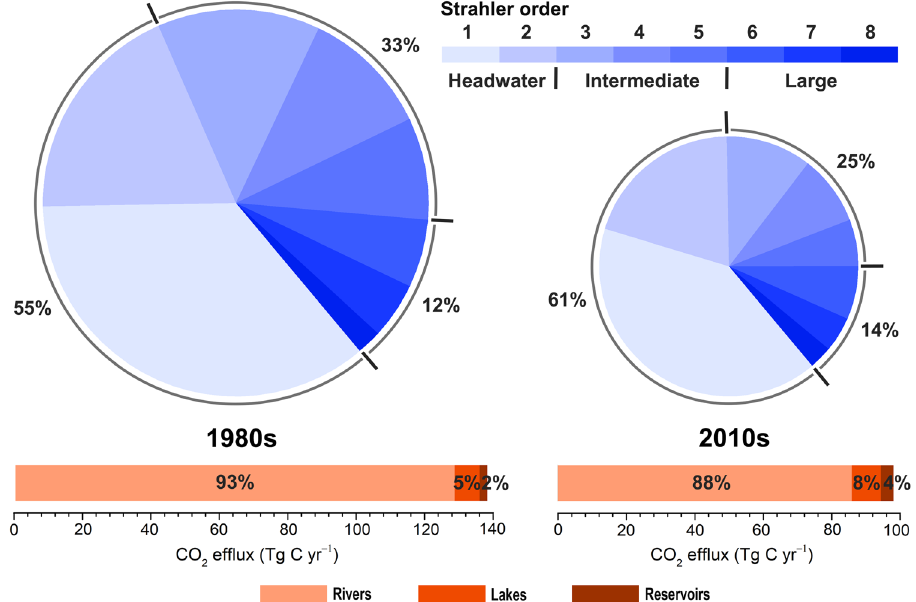
Fig. 3 Comparison of CO 2 emissions from Chinese inland waters in the 1980s and 2010s. Upper: relative importance of different Strahler order streams in riverine CO 2 evasion. Lower: relative contributions of rivers, lakes, and reservoirs in total CO 2 ef fl ux. The sizes of the pie charts are proportional to the riverine CO 2 evasion fl ux. Percentage contributions are given for headwater ( fi rst – second orders), intermediate (third – fi fth orders), and large (sixth – eighth orders)